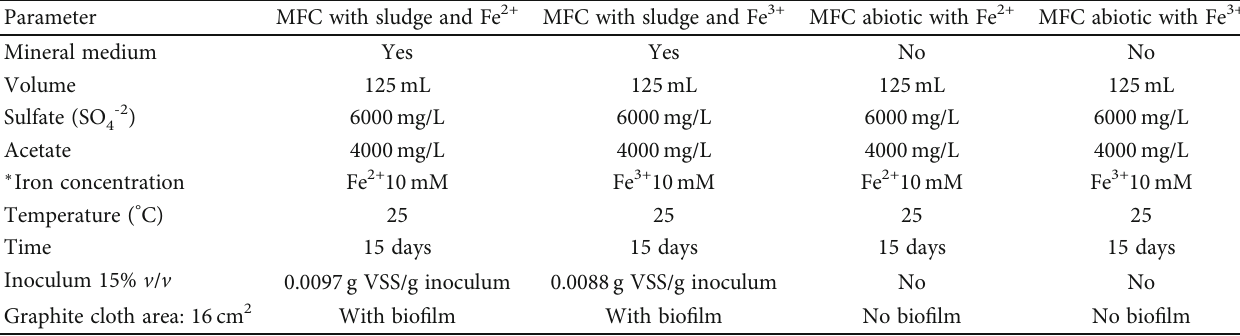
Table 1: Experimental conditions for the batch tests for each MFC.